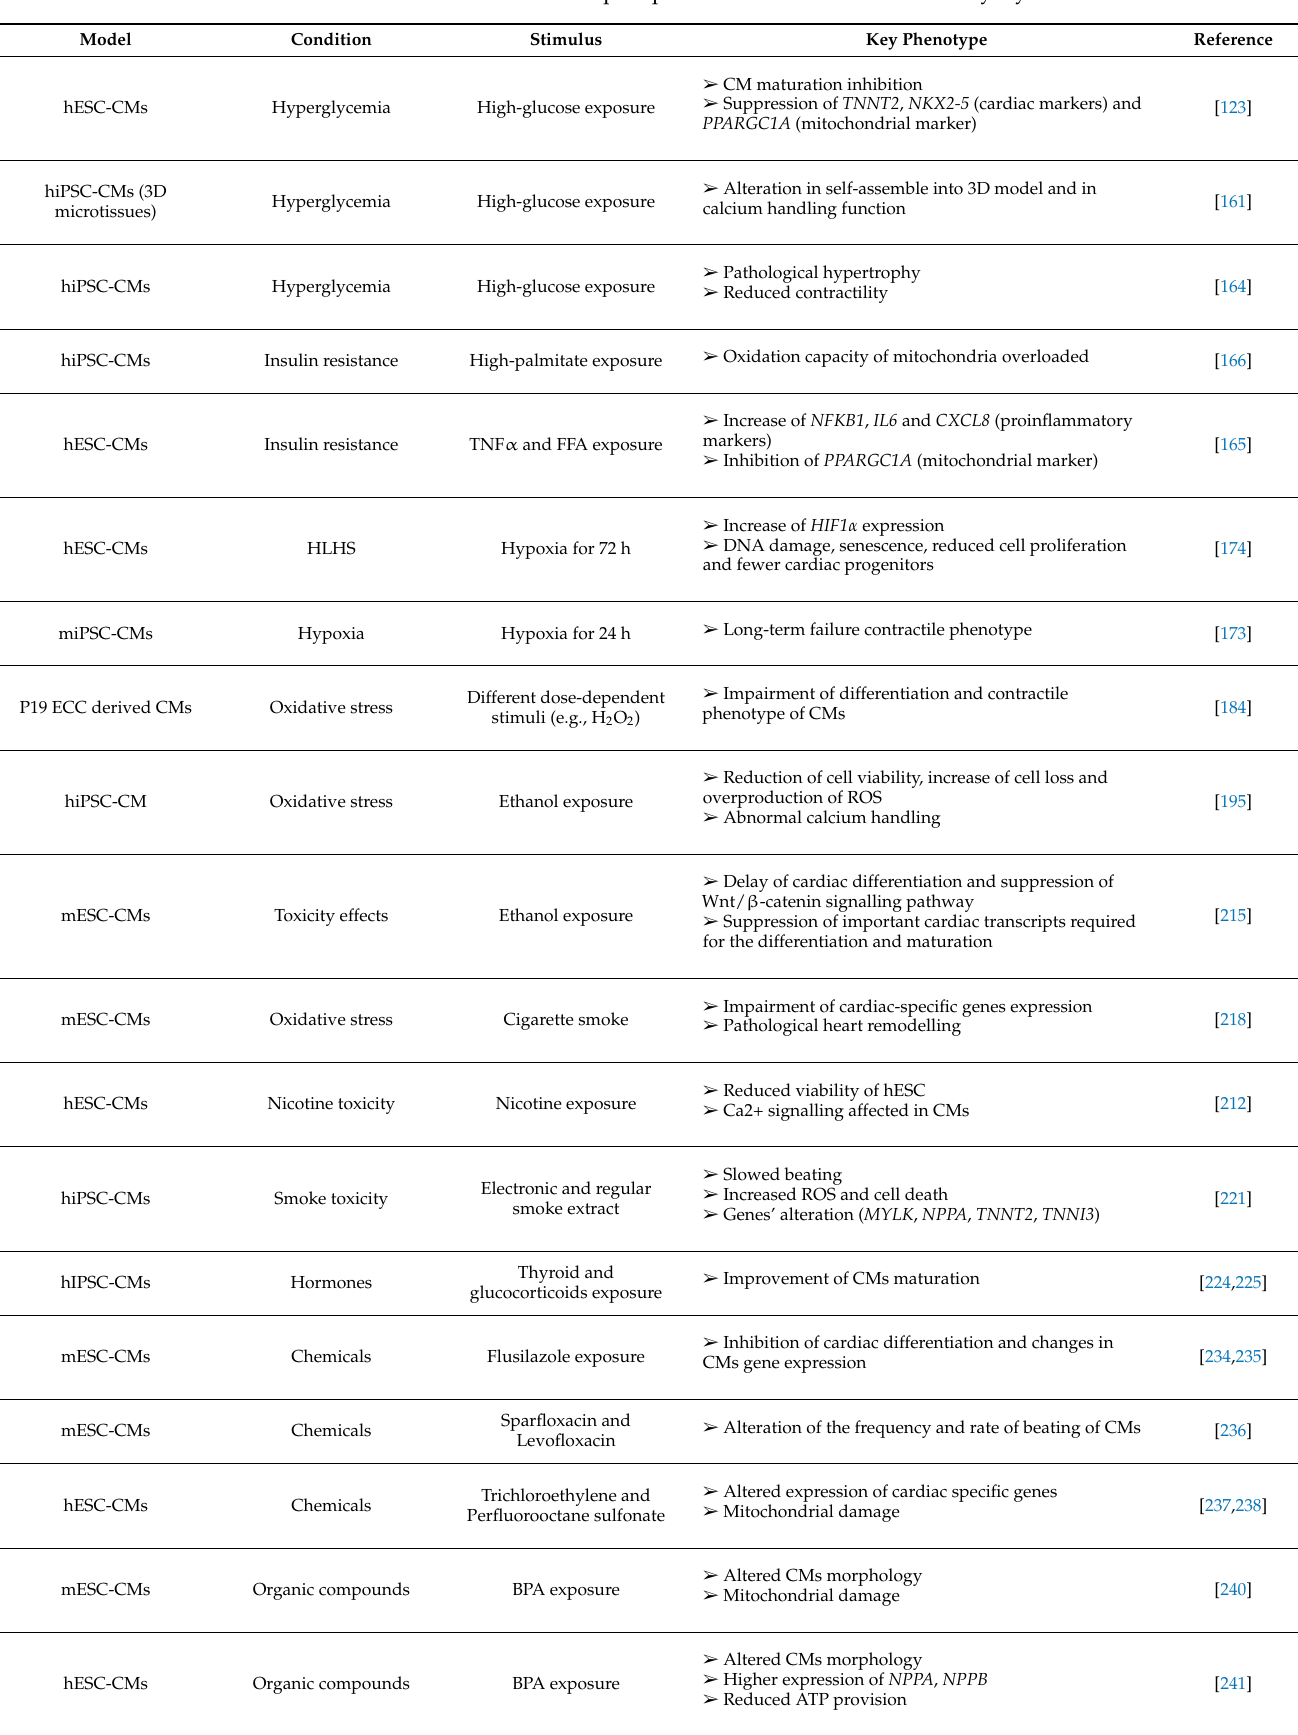
Table 2. Effect of several stressors on pluripotent stem cell-derived